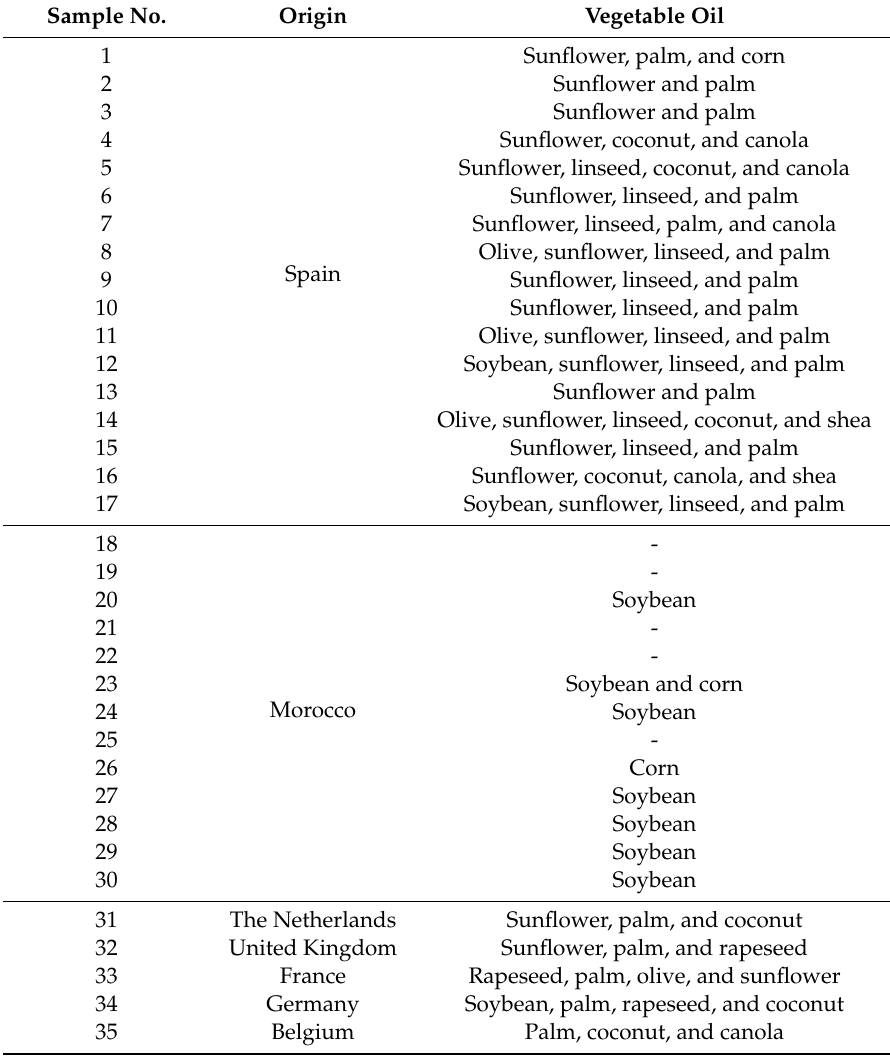
Table 1. Types of vegetable oils present in the